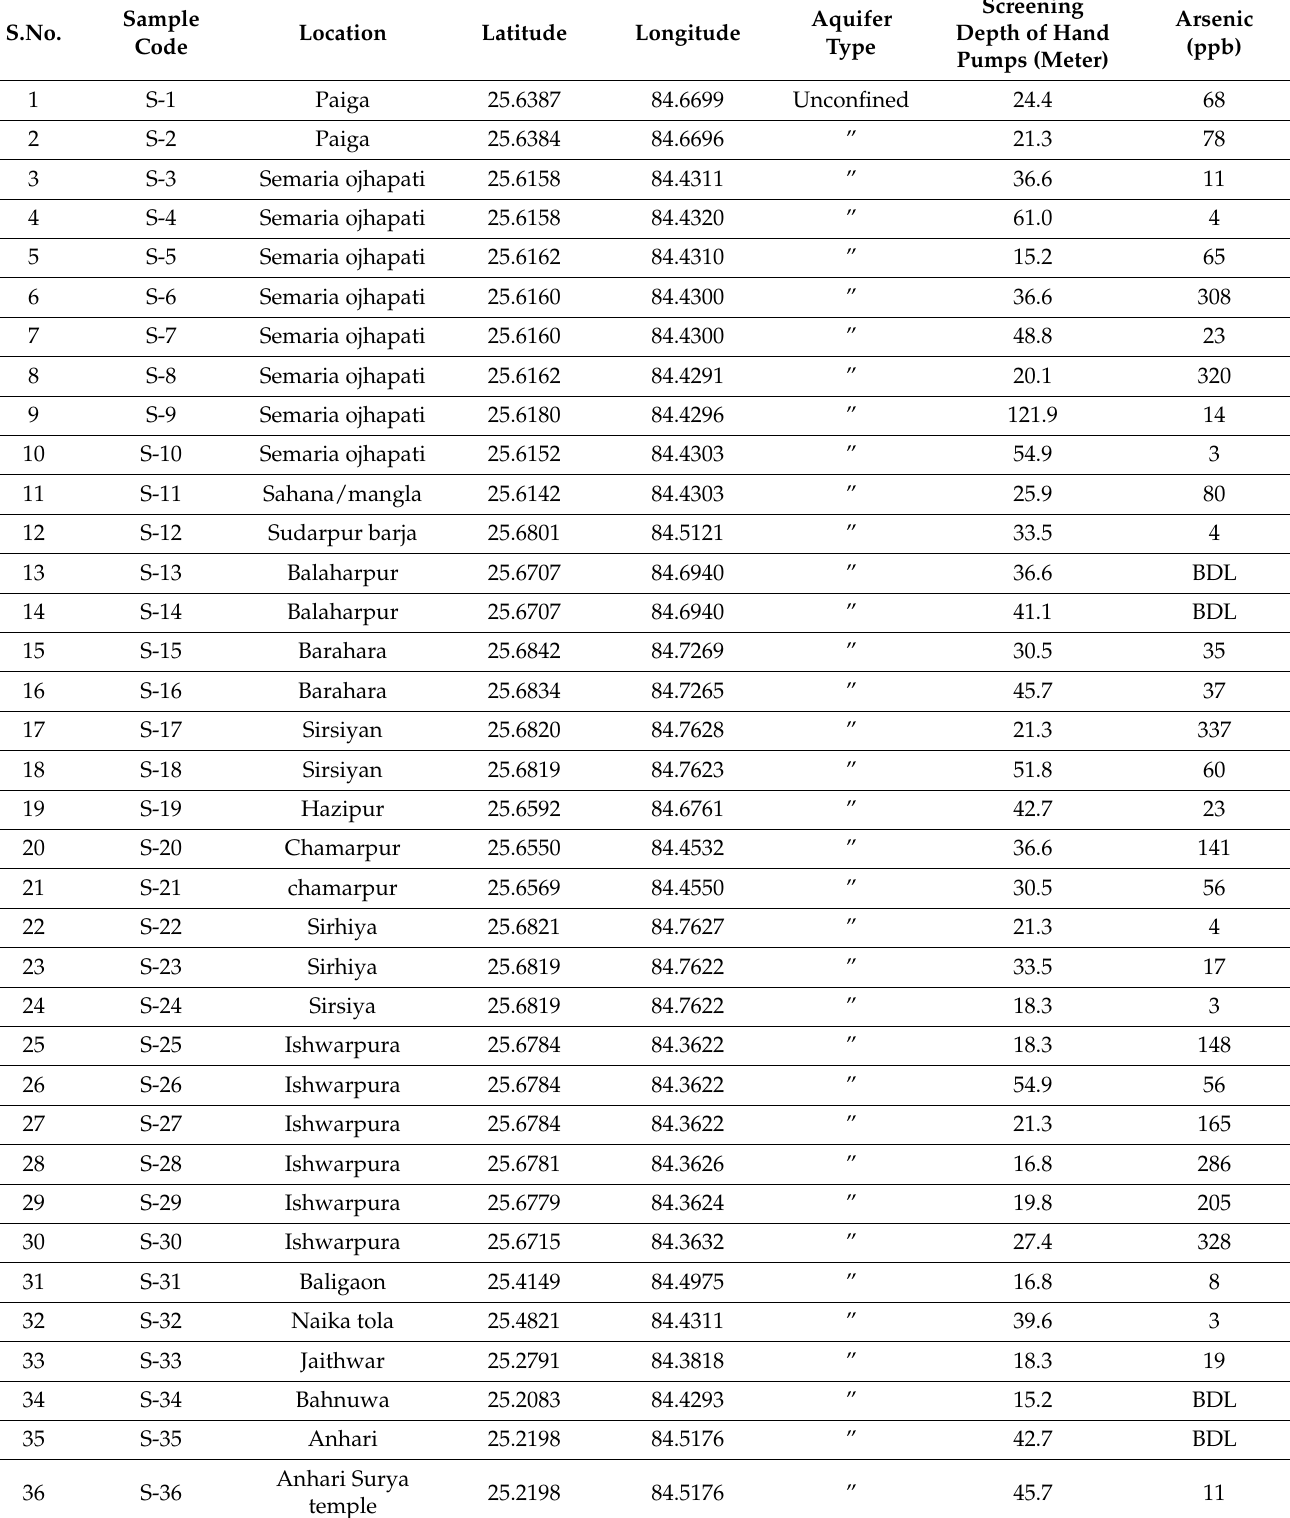
Table A1. Sampling details with arsenic concentration in the study